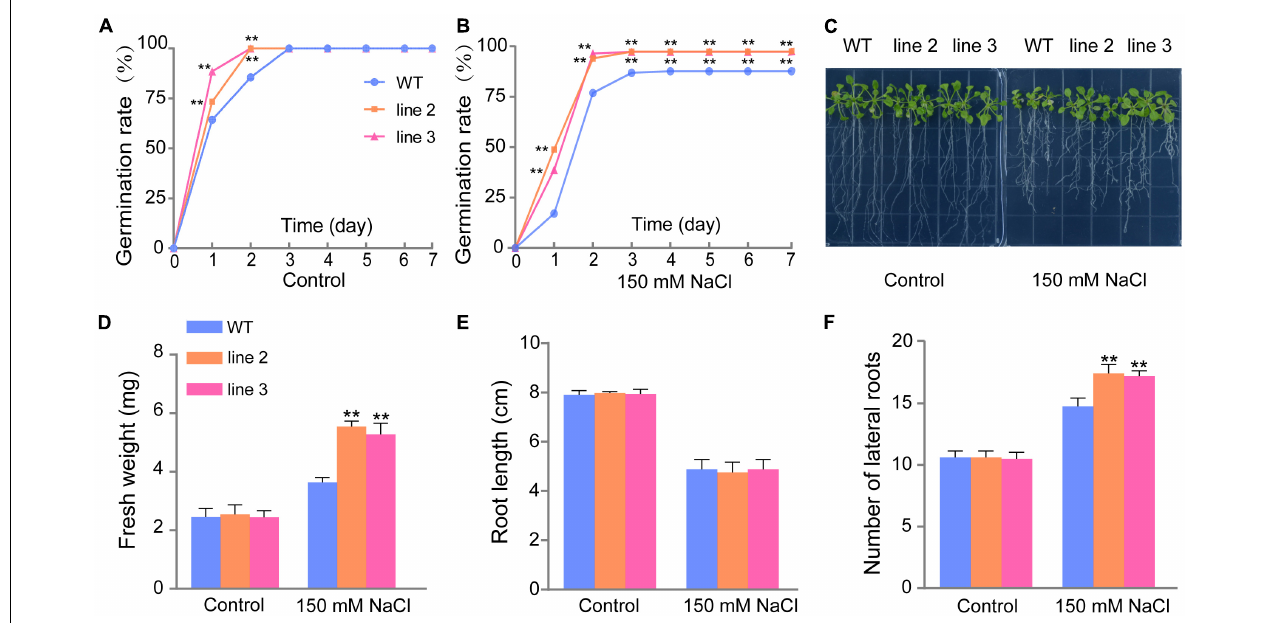
FIGURE 3 | Germination rate, fresh weight, root length, and number of lateral roots comparisons of WT plants and two ScDREB5 transgenic Arabidopsis lines. (A,B) Germination percentages of WT and ScDREB5 -transformed seeds under normal and salt stress conditions. The germination percentages were calculated as the number of germinated seeds divided by the total number of seeds. Values are means ± SE of three replicates (n = 40–60 seeds). Asterisks indicate statistically significant differences from WT (** P < 0.01). (C) Phenotype observation of WT and transgenic plants under normal and salt stress conditions. (D–F) Analysis of the fresh weight (mg), root length (cm), and number of lateral roots. Data are displayed with mean ± SE using at least 20 plants per replicates. Significant difference compared with WT plants with the same treatment. LSD multiple comparison test was used: * p < 0.05, ** p < 0.01.